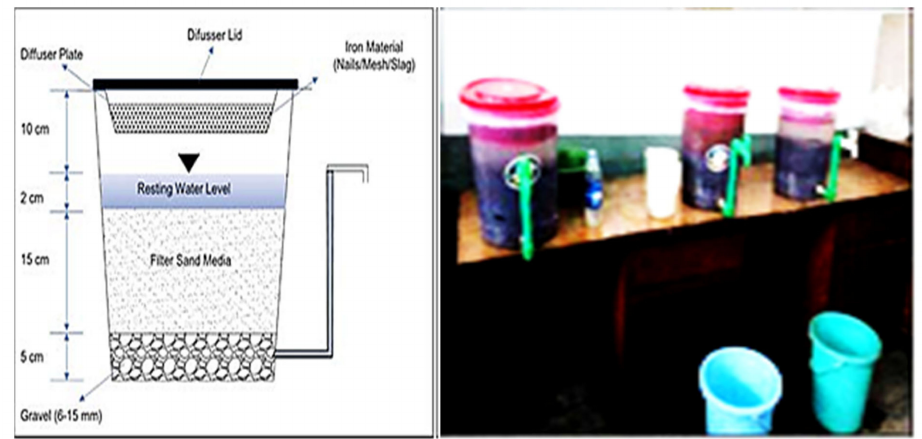
Figure 7. Components of a Pakistan Arsenic Filter (PAF) and its use for arsenic removal from groundwater [162]. Reproduced with